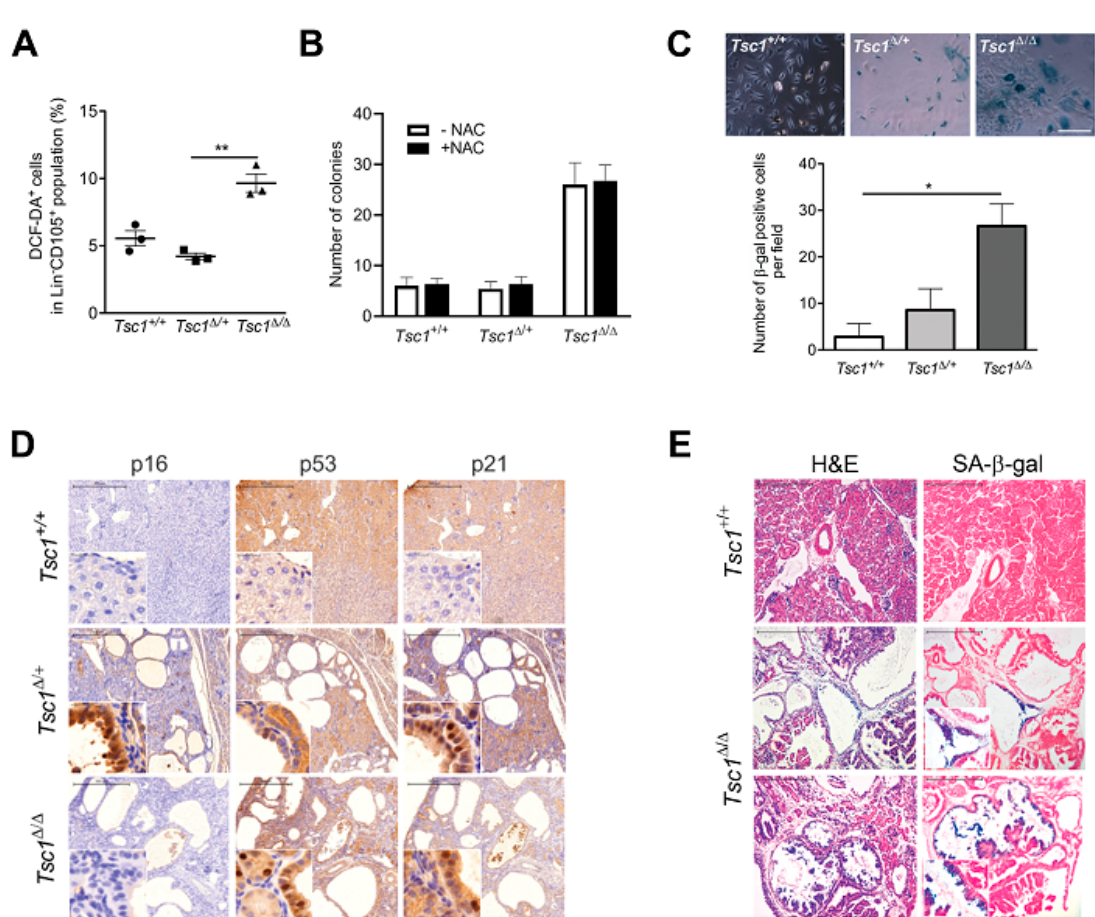
Figure 4. Tsc1 suppression leads to ROS production and premature senescence. ( A ) Levels of ROS in monolayer cultures of Lin - CD105 + cells derived from Tsc1 +/+ , Tsc1 ∆ /+ , and Tsc1 ∆ / ∆ 28 d old mice determined by flow cytometry following incubation with DCF-DA. Data presented are means ± SD ( n = 3 animals per group). ( B ) CFU-F assay of primary BM Lin - isolates in the presence or absence of the antioxidant NAC. ( C ) SA β -gal staining following extended culture (36 days) of BM-MSCs. Images show SA β -gal positive cells for each genotype. Scale bar: 100 µ m. The plot indicates the quantification of SA β -gal positive cells. Values represent average counts of 5 fields for each genotype. ( D ) Representative images of sections of Tsc1 +/+ , Tsc1 ∆ /+ , and Tsc1 ∆ / ∆ kidneys from 28 day old littermates stained for p16, p21, and p53. Scale bar: 500 µ m. ( E ) Representative images of Tsc1 +/+ and Tsc1 ∆ / ∆ kidneys stained with H&E or SA β -gal. Scale bar: 250 µ m. Inset images show 10 × (panel D) and 4 × (panel E) magnifications of hyperproliferative cystic regions with positive staining for cell senescent markers.* p < 0.05; ** p < 0.01.